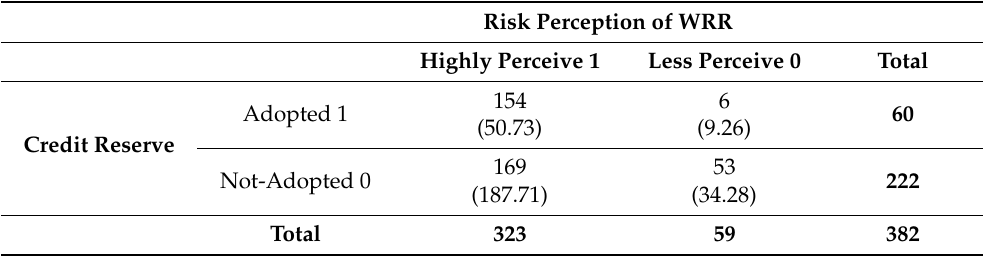
Table 10. Observed and Estimated Expected (in Parentheses) Counts for farmers’ risk perception of WRR and their choice to adopt credit reserve as a risk management